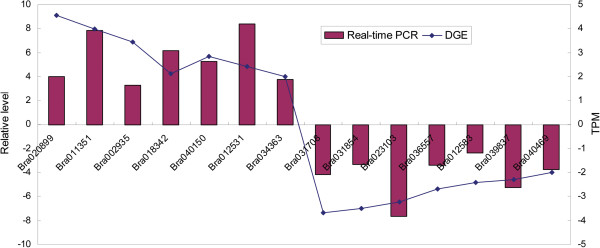
Real-time PCR validations of tag-mapped genes. Relative level, (2−△CT△CT); TPM, log2 Ratio (Fer/Ste).